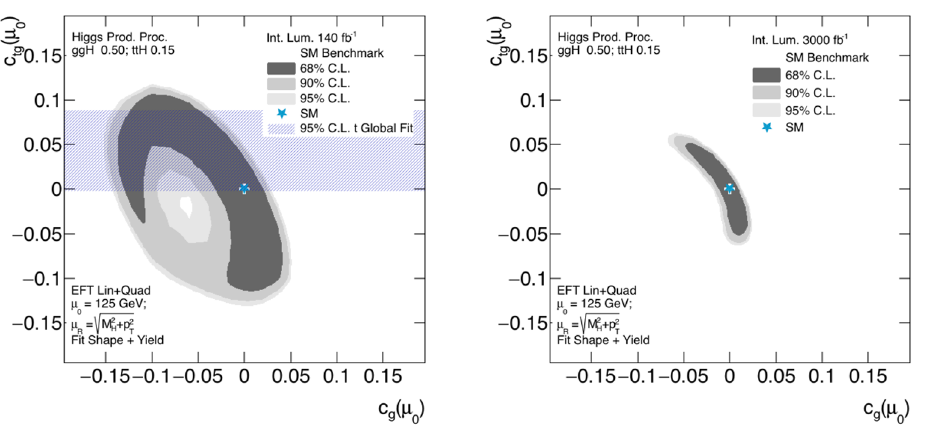
Figure 11. Constraints on the c g and c tg coefficients at 68% (dark grey), 90% (mid grey) and 95% (light grey) C.L. obtained from the fit including ggF and t ¯ tH SMEFT contributions to the SM-like spectrum shape and Higgs signal rate on 200 < p H < 2000 GeV with 140 fb − 1 (left panel) T and 3000 fb − 1 (right panel). The SM value is indicated by the blue star and the best fit value by the white marker. The shaded horizontal strip indicates the 95% C.L. interval for c tg from the top quark fit of ref. [71] translated to our definition of c tg ( µ 0 ) . Notice also the reduced range compared to figure